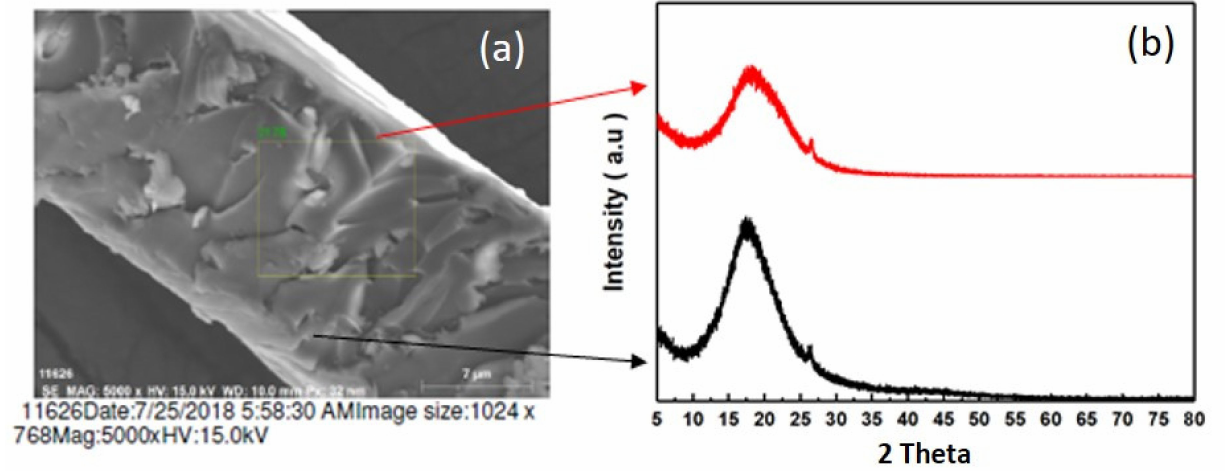
Figure 6. ( a ) SEM image and ( b ) XRD spectroscopy of the epoxy-AMG nanocomposite.